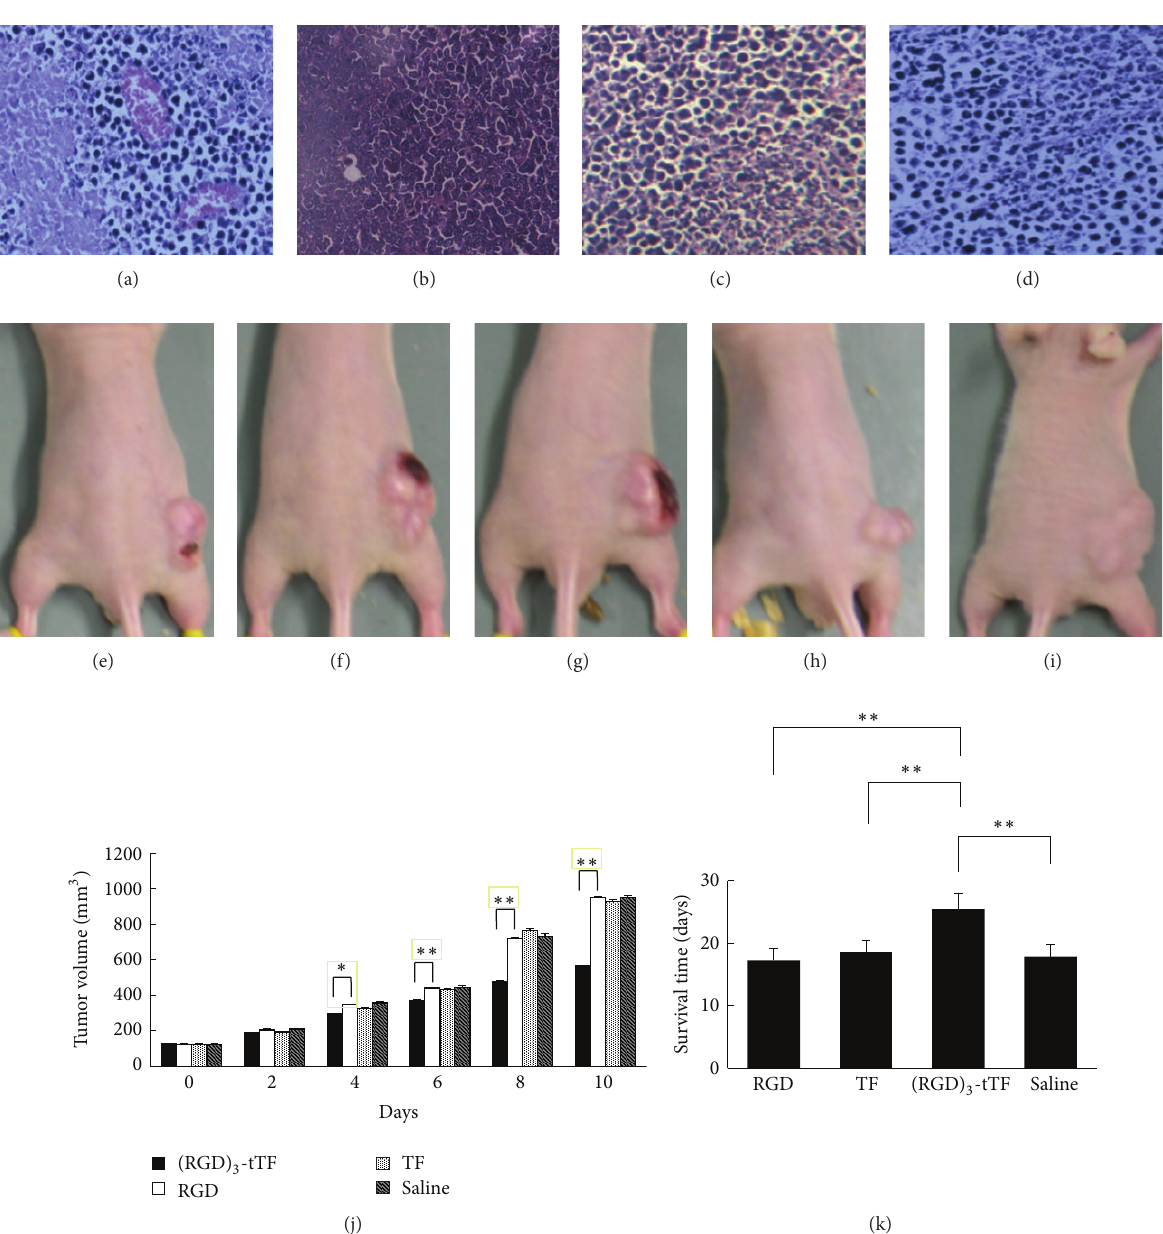
Figure 6: Antitumor effect in vivo . Upper panel: histological analysis of tumor tissues in mice treated with drugs. (a) Necrosis and thrombosis werefoundintissuesofmicetreatedwith(RGD) 3 -tTF;(b)nonecrosisandthrombosisinmicetreatedwithTF;(c)nonecrosisandthrombosis in mice treated with RGD; (d) no necrosis and thrombosis in mice treated with saline (bar = 50 𝜇 m). Middle panel: tumor necrosis after treatment. (e) Necrosis was found at 4 days after injection of (RGD) 3 -tTF; (f) necrosis was found at 6 days after injection of (RGD) 3 -tTF; (g) necrosis was found at 8 days after injection of (RGD) 3 -tTF; (h) no necrosis in mice treated with TF; (i) no necrosis in mice treated with RGD. Lower panel: (j) tumor volume of mice treated with drugs. The tumor volume in mice treated with (RGD) 3 -tTF was significantly smaller than that in mice treated with TF, RGD, or saline; there was no significant difference between tTF and RGD ( ∗ 𝑃 < 0.05, ∗∗ 𝑃 < 0.01 ). (k) Surviving time of tumor-bearing mice. Surviving time of tumor-bearing mice treated with (RGD) 3 -tTF was significantly longer than that in TF or RGD groups; there was no significant difference between tTF and RGD ( ∗ 𝑃 < 0.05, ∗∗ 𝑃 < 0.01